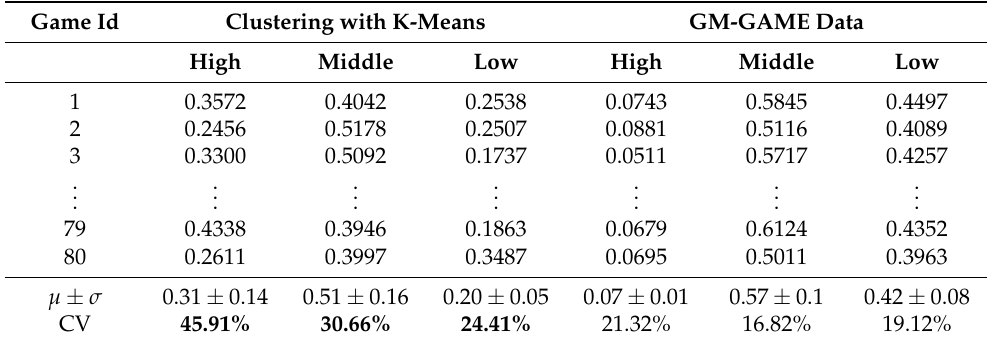
Table 4. Comparison of clustering algorithm and GM-GAME data for describing game load (63 games) based on CV. Bolded values mark higher explanatory power for a particular